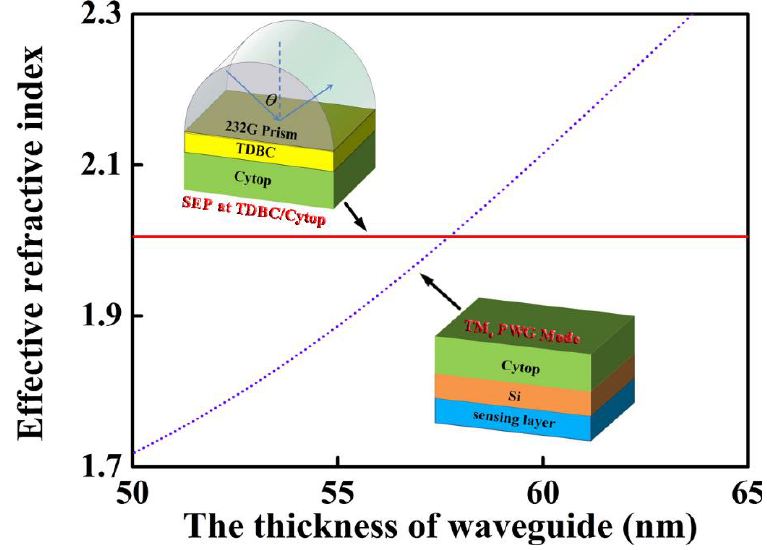
Figure 2. Dispersion relations of surface exciton polariton (SEP) mode (red solid line) and waveguide mode (WGM) (violet dotted line).